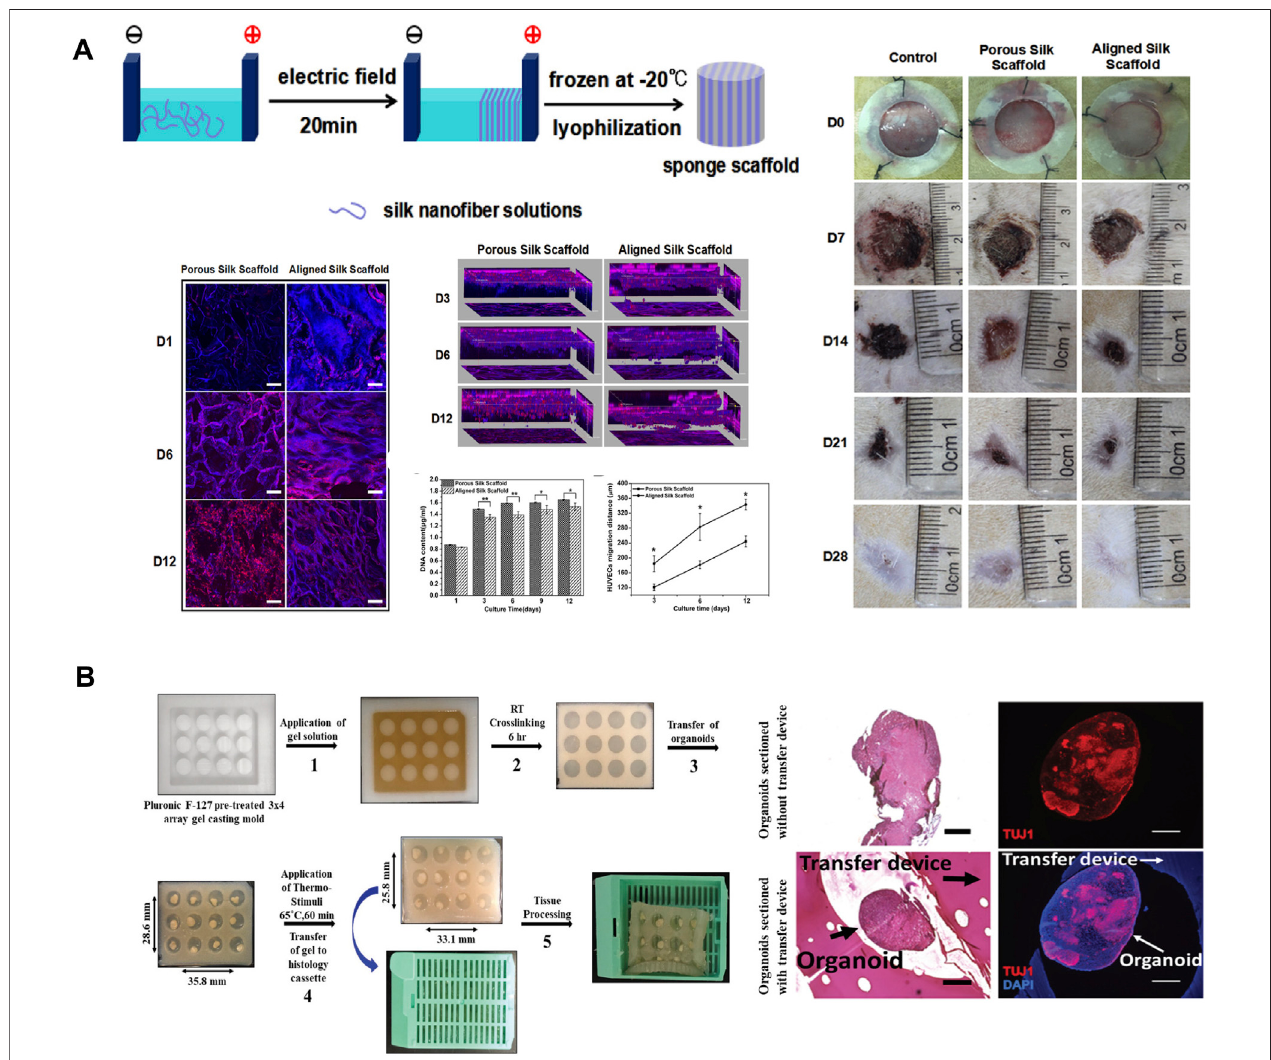
FIGURE 7 | Silk-based biomaterials in 3D cell culture. (A) The silk nano fi bers were aligned in an electric fi eld and then lyophilized to obtain aligned silk nano fi ber scaffolds with biomimetic nanostructures. Human umbilical vein endothelial cells migrated faster and deeper on the aligned silk scaffold because of the aligned hierarchical structures. Rat skin full-thickness defect model suggested that aligned silk scaffolds provided better microenvironments for wound closure than porous silk scaffolds. Adapted with permission from ref (Lu et al., 2018). Copyright 2018 American Chemical Society. (B) Schematic diagram of thermo-responsive SELP devicesforhigh throughput histologyanalysis.Histologicalanalysesand immuno fl uorescent stainingofcerebral organoidssuggestthattheSELPembedded organoids appear to maintain more de fi ned edges, present fewer tears, and show more compact tissue organization. Adapted with permission from ref (Parker et al., 2020). Copyright 2020